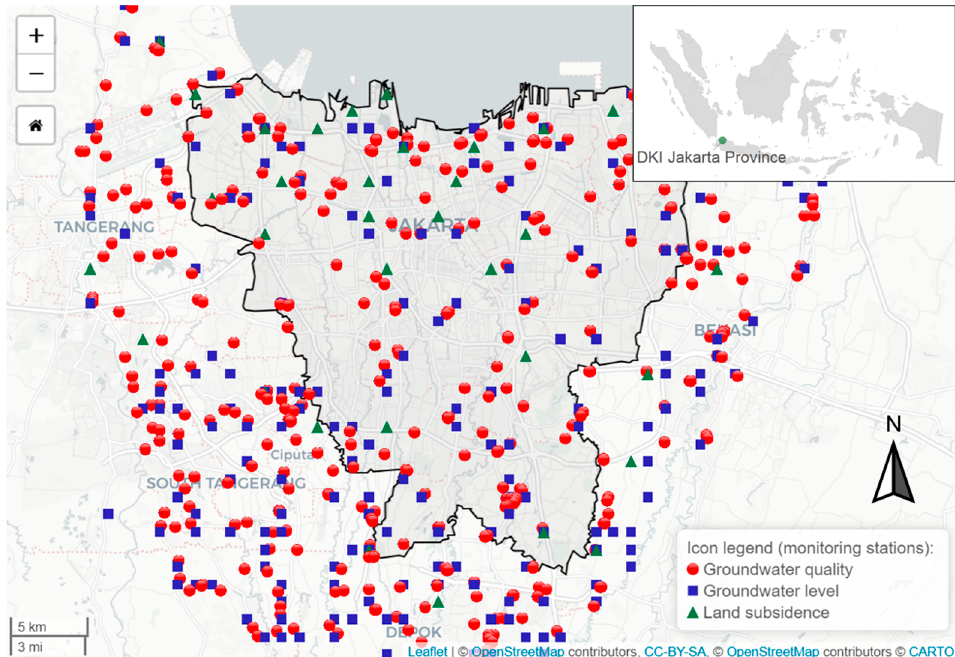
Figure 2. GPS stations and monitoring wells retrieved by web scraping [20].